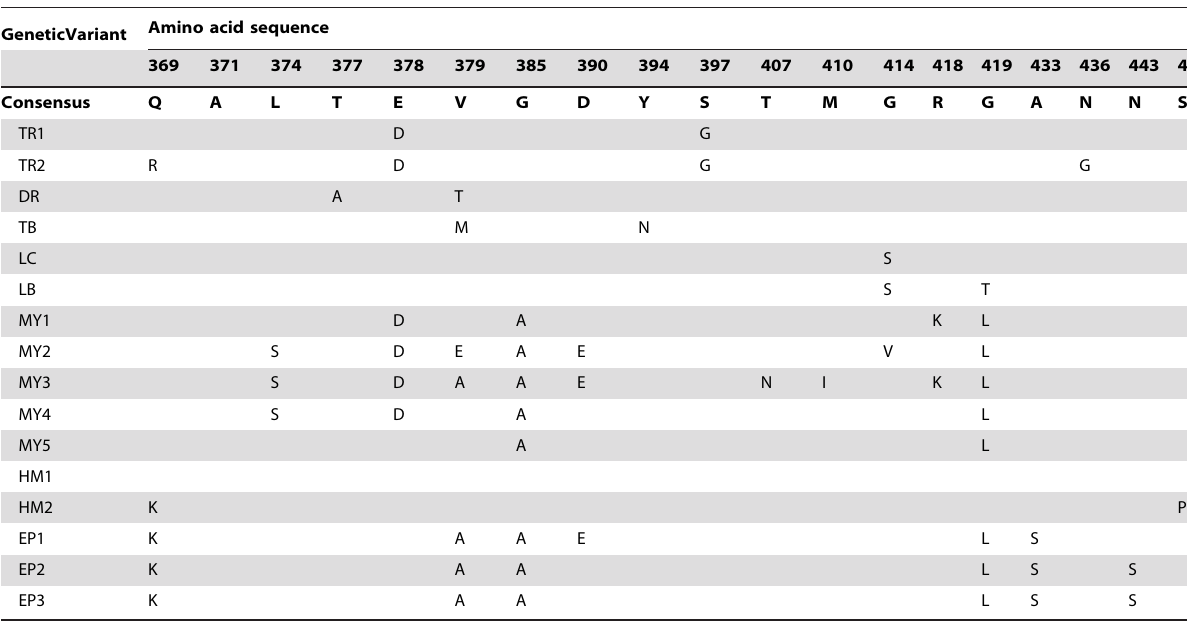
GeneticVariant Amino acid